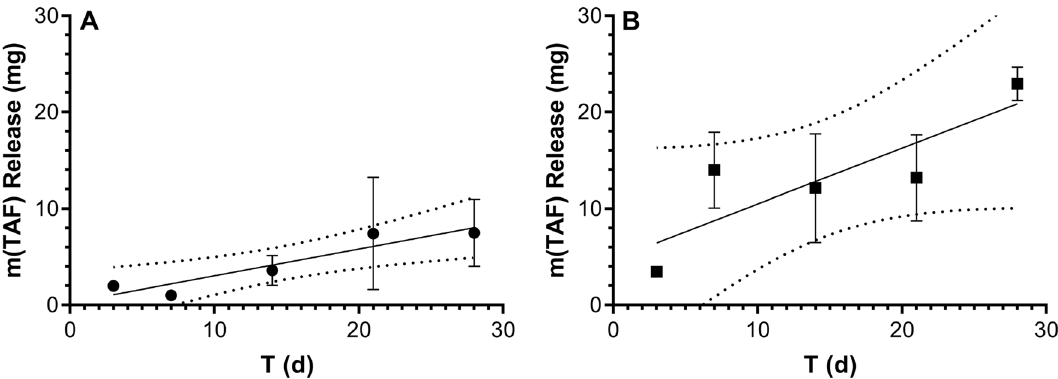
Figure 1. In vivo drug release from TAF implants in C57BL/6 J mice ( N = 3 per timepoint) estimated via residual drug analysis in used devices. Symbols correspond to means ± SEM; solid line, simple linear regression; broken lines, 95% confidence bands. ( A ) Low-releasing implants; slope = 0.28 ± 0.06 mg d -1 ; R 2 = 0.875. ( B ) High- releasing implants; slope = 0.58 ± 0.21 mg d -1 ; R 2 =